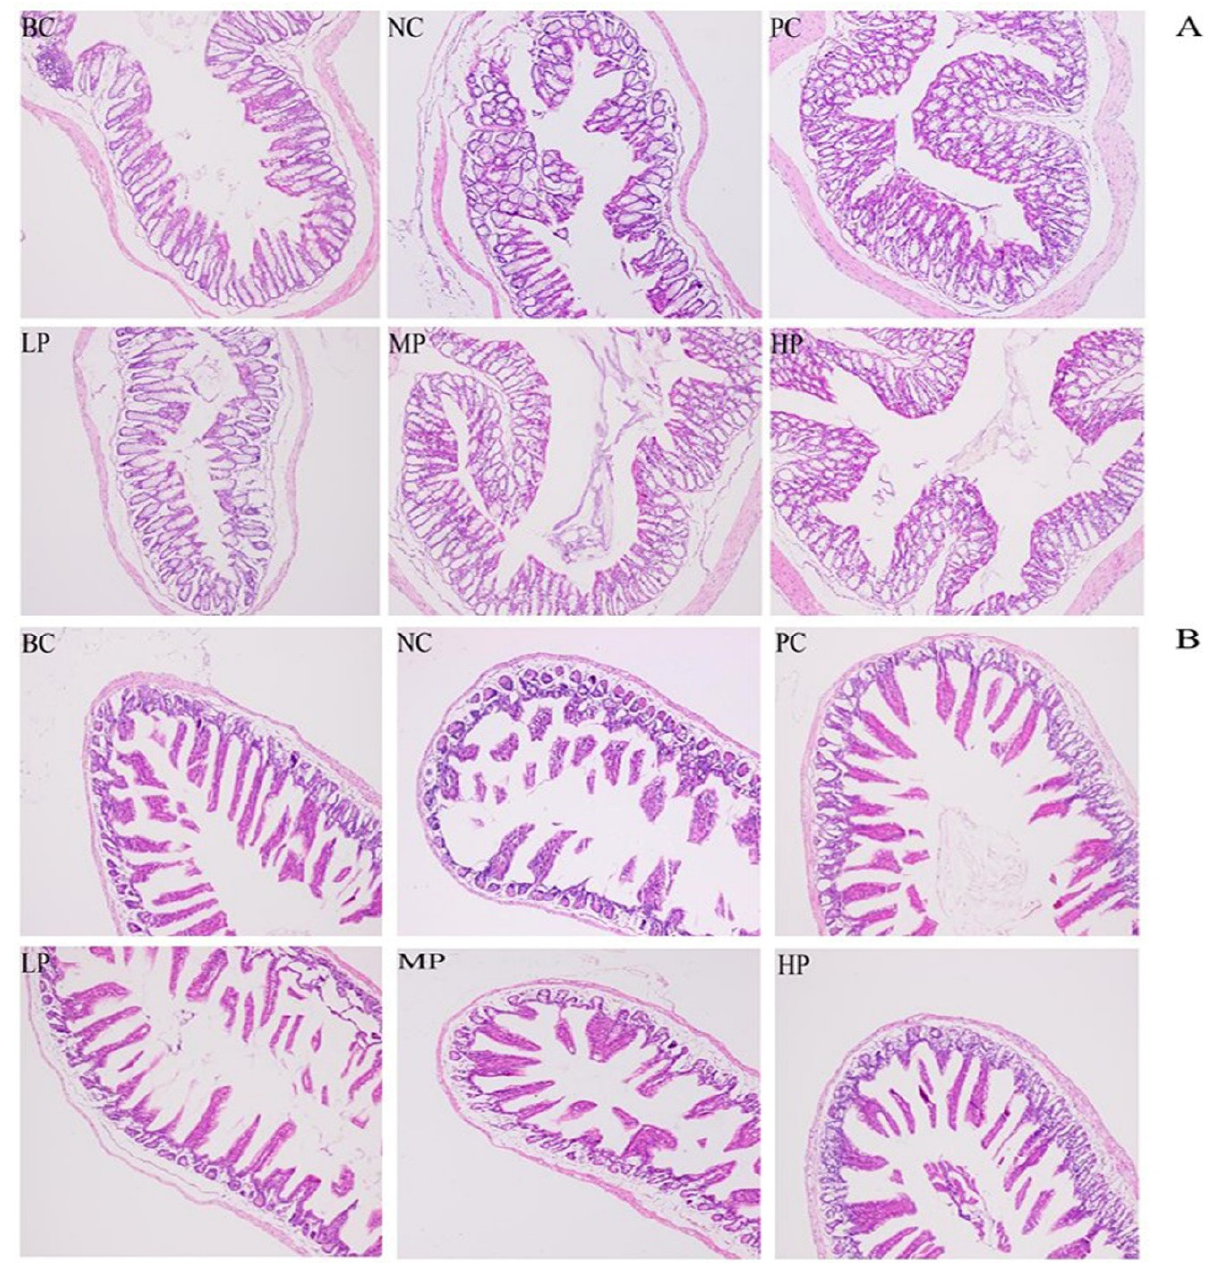
Figure 3. Histopathological observation of the colon ( A ) and small intestine ( B ) (100×). BC (blank control) represents healthy mice; NC (negative control) represents AAD mice without treatment; PC (positive control) represents AAD mice administrated with 200 mg/kg BW of inulin; LP, MP and HP represent AAD mice administrated with low-dosage (100 mg/kg BW), middle-dosage (200 mg/kg BW) and high-dosage (400 mg/kg BW) of BSP, respectively.